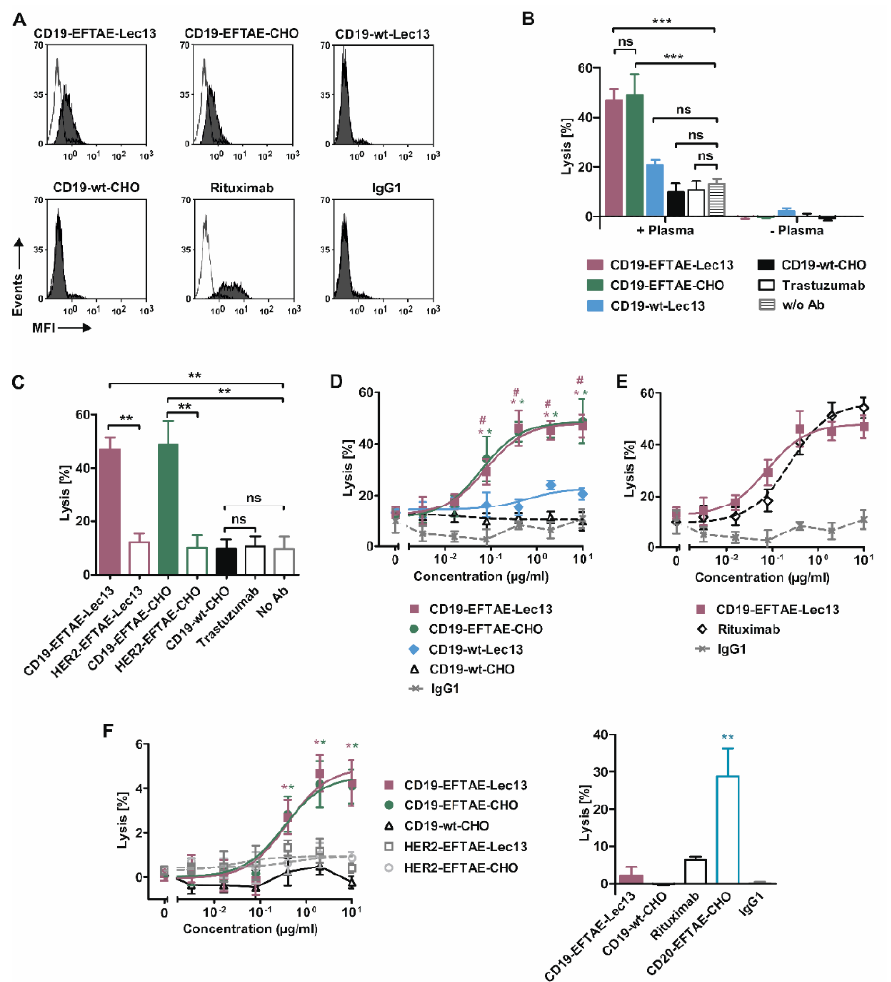
Figure 4. C1q binding capacities and induction of CDC by CD19 antibody versions. ( A ) Raji cells were left untreated (white peaks) or coated with antibodies CD19-wt-CHO, CD19-EFTAE-CHO, CD19-wt-Lec13 or CD19-EFTAE-Lec13 (grey peaks) at a concentration of 50 µ g / mL. Then cells were incubated with human serum (1%) as a source of C1q and C1q binding to antibody coated cells was determined using a FITC-conjugated mouse anti-human C1q antibody and flow cytometry. Rituximab, which binds C1q e ffi ciently, and trastuzumab, which does not react with HER2-negative Raji cells, were included as control reagents. MFI, mean fluorescence intensity. ( B ) CDC by CD19 antibodies was determined by 51Cr release experiments with Ramos cells as target cells in the presence or in the absence of 25% human plasma. Antibodies were analyzed at a concentration of 10 µ g / mL. Bars represent mean values of specific lysis ± SEM. Significant di ff erences between antibody-treated groups and the control group without any added antibody (w / o Ab) are indicated (***, p ≤ 0.001; ns, not significant; n = 3). ( C ) CDC against Ramos by antibodies CD19-EFTAE-Lec13, CD19-EFTAE-CHO and CD19-wt-CHO compared to corresponding engineered control antibodies against HER2 and the native anti-HER2